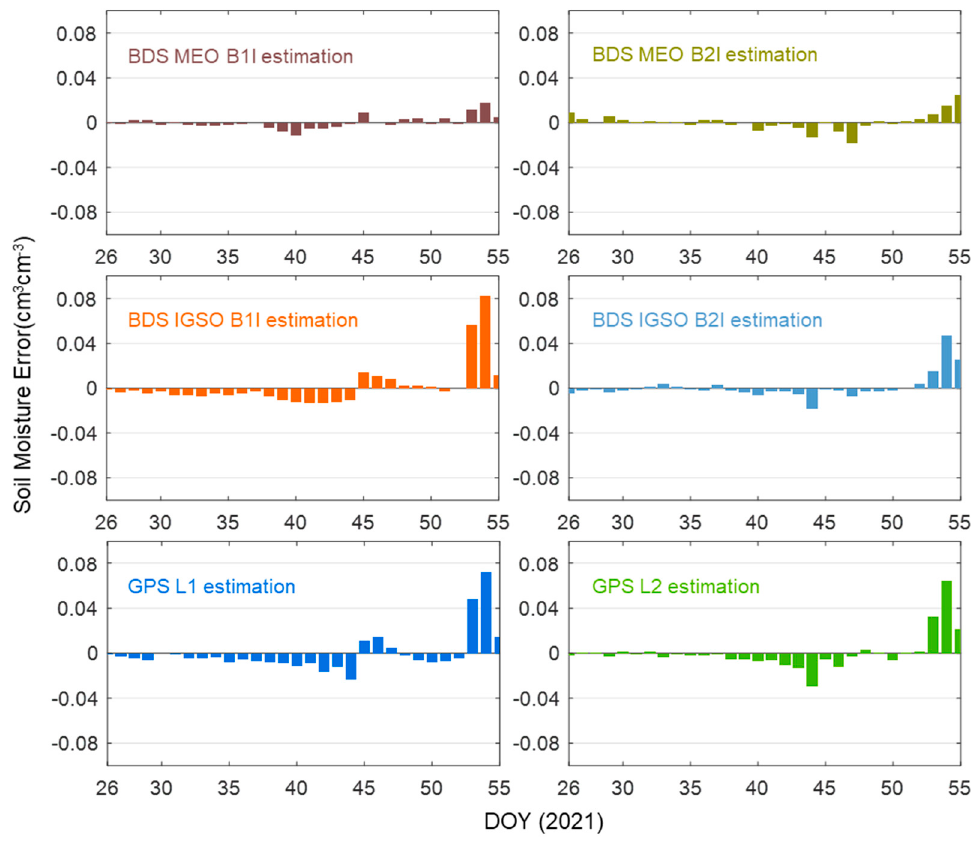
Figure 12. Multi-satellite soil moisture estimation results of BDS and GPS satellites.